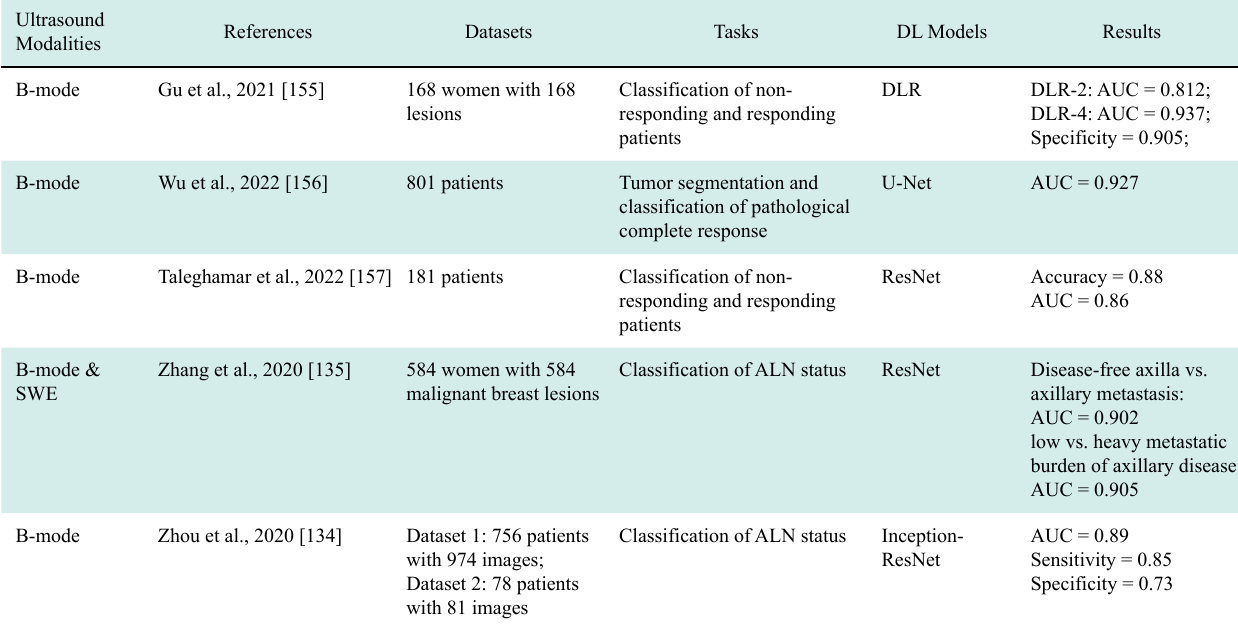
Table 4 Deep learning for breast cancer response evaluation and outcome prediction in ultrasound Ultrasound